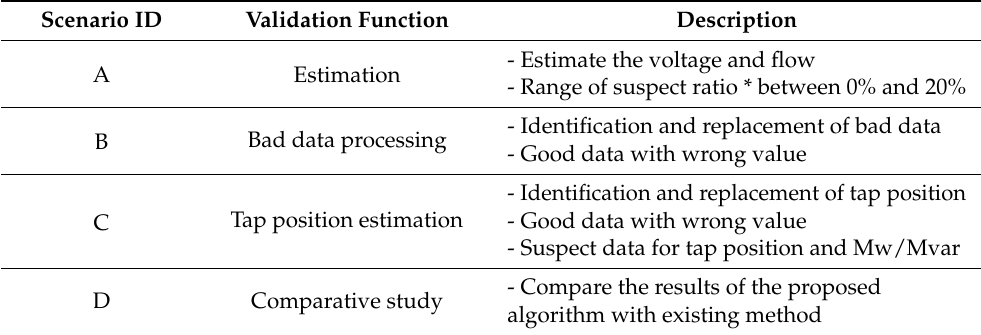
Table 4. Scenario for validating the state estimation